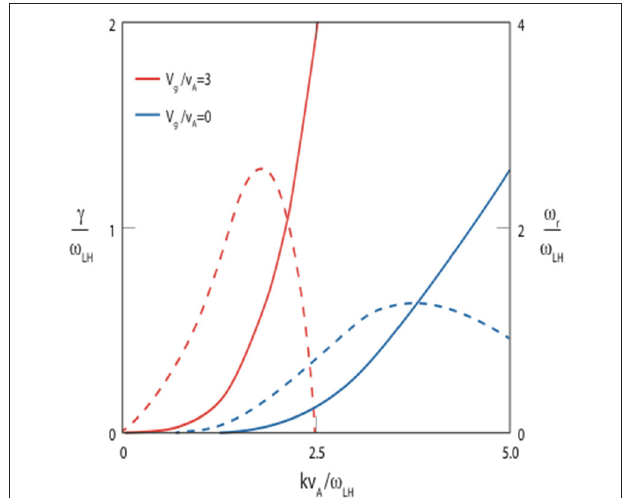
FIGURE 4 | Left panels show schematic of expanding plasma cloud compressing into a thin shell, showing the radial electric field and electron and ion azimuthal drifts, from Figure 1 in Winske (1989), reproduced with permission from the American Institute of Physics. Right panel shows corresponding density profile, direction of the density gradient, the deceleration, the radial electric field, the cross-field drift and the magnetic field in slab geometry used in the linear analysis, from Figure 1 in Winske (1988), reproduced with permission from The American Geophysical Union.